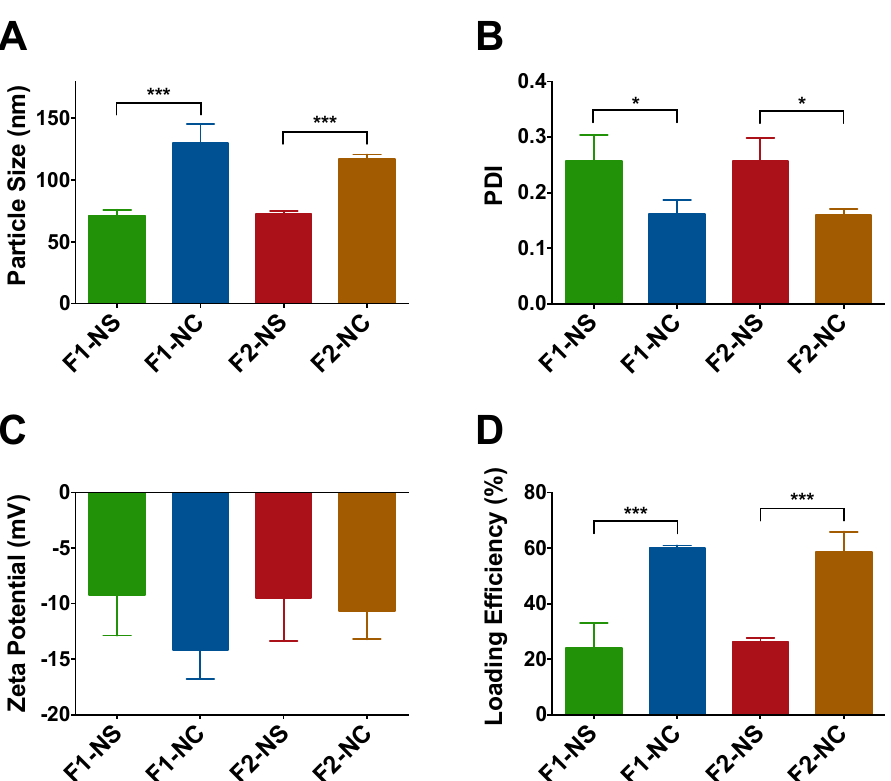
Figure 2. Characterization of TQ NPs prepared in this study. ( A ) Particle size of NC-based formulations F1-NC and F2-NC was 1.8 and 1.6 fold larger, respectively, compared to the NS-based formulations F1-NS and F2-NS due to the presence of the oil core; ( B ) NC-based formulations were associated with significantly lower polydispersity index (PDI) values, indicating greater monodispersity compared to their NS-based counterparts; ( C ) all NP formulations displayed partially negative zeta potential values; ( D ) the NC architecture is more favorable for TQ loading as evidenced by the significant increase in loading efficiency by 2.5 and 2.2 fold in F1-NC and F2-NC, respectively, compared to F1-NS and F2-NS. All results are presented as mean ± SD from at least three different batches of NPs. * p < 0.05, *** p < 0.001.